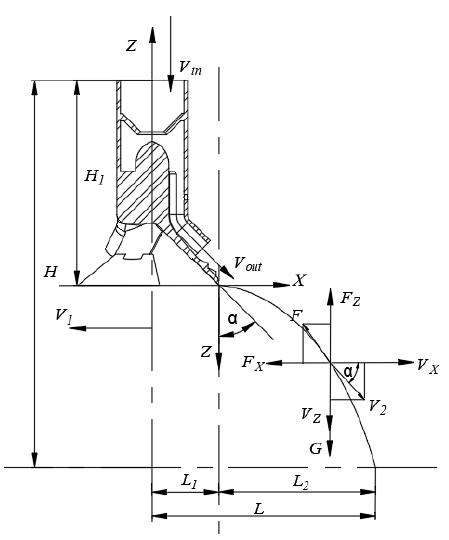
Figure 4. Fertilizer vertical spreading movement.